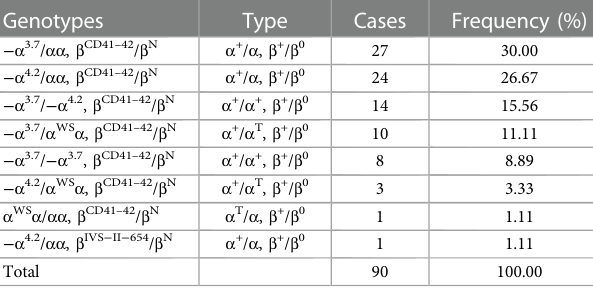
TABLE 5 Allele frequencies of α -thalassemia mutations in the newborns of Li in Hainan province. Affected alleles